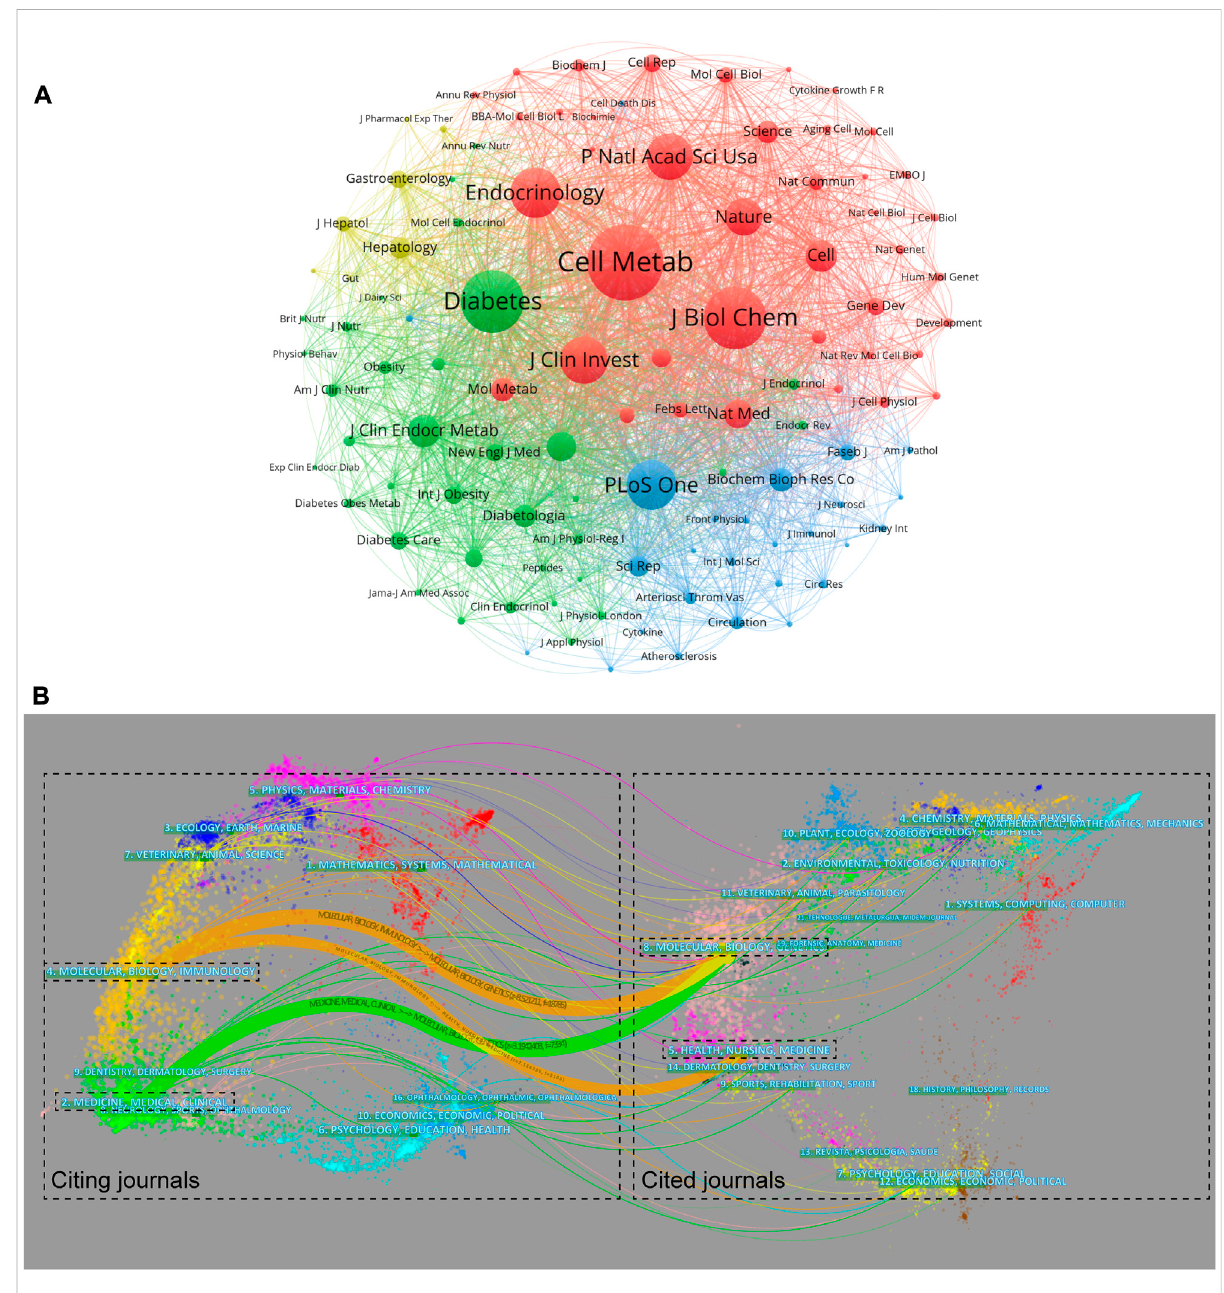
FIGURE 4 Core journalsinthe fi eldofFGF-21research. (A) Clusteringofco-citationamong journals. Eachnoderepresentsajournal, andeachline means aco-citedrelationship.Thenodesizeisproportionaltotheco-citedlinkstrength,andthenodecolorre fl ectstheclustertowhichitbelongs. (B) The dual-mapoverlayofarticlescitingFGF-21research.Theleftandrightsidesarethecitingandcitedjournals,respectively,andthelinepathrepresents the citation